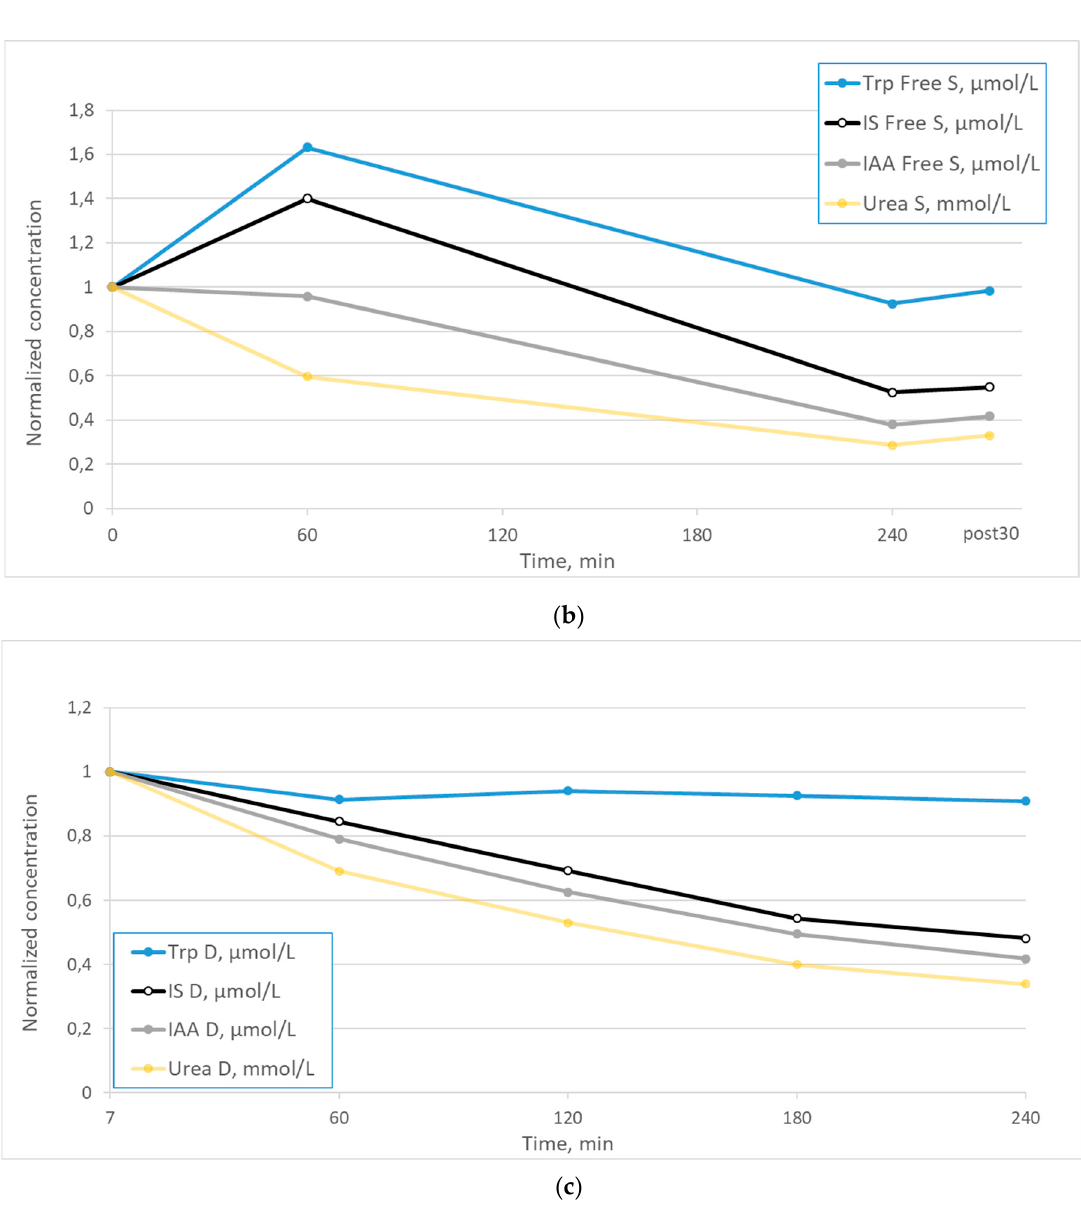
Figure A1. Mean concentrations normalized for the baseline pre-dialysis value, at di ff erent time points during the dialysis sessions for Trp, IS, IAA and urea for ( a ) total serum values; ( b ) free serum values; and ( c ) dialysate values. P values are shown on Figure